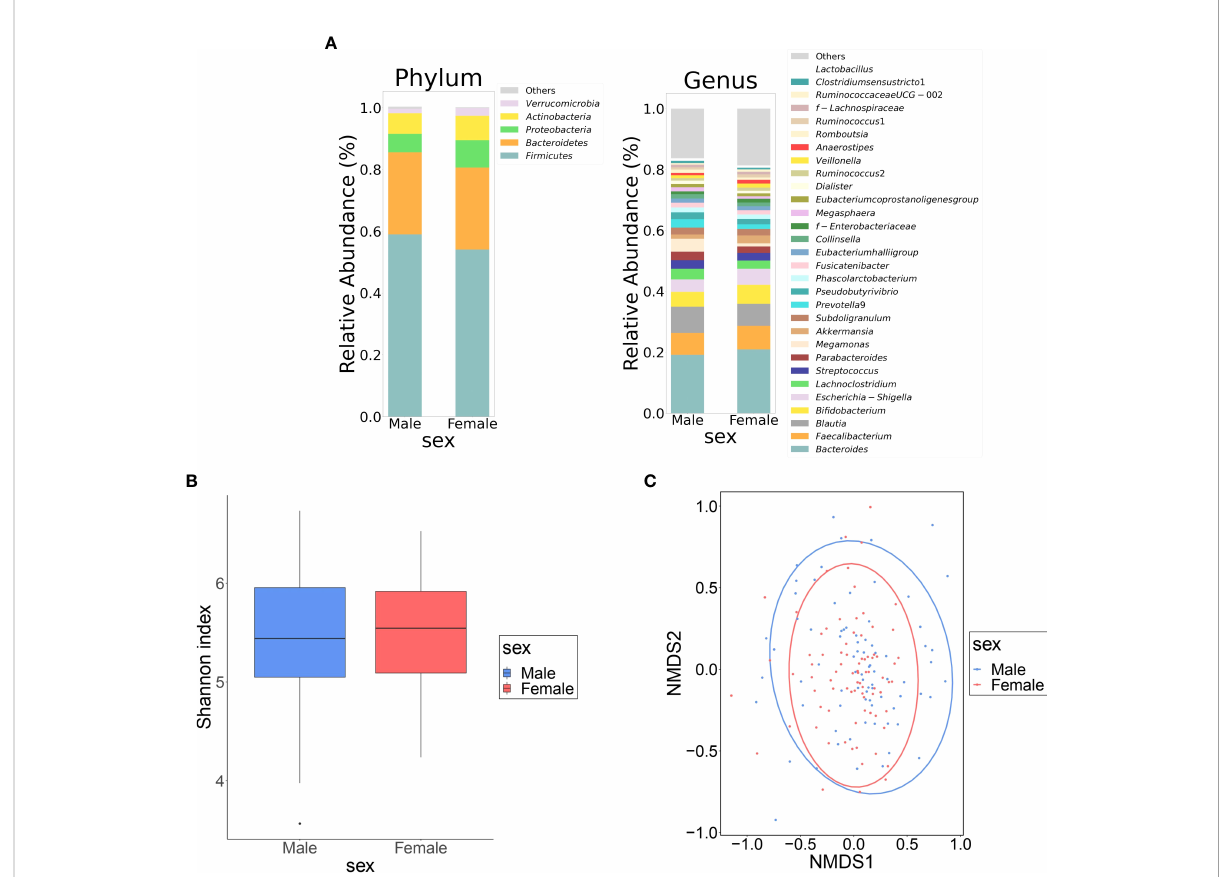
FIGURE 1 Differences in gut microbiota between female and male groups. (A) Comparison of relative abundance ratios at the phylum and genus level for the top 30 bacterial genera with mean abundance ratios by sex. (B) The difference in a -diversity calculated using Shannon index, 5,000 depths. One sample that failed to be sequenced was excluded. ( P = 0.490, Quade ’ s nonparametric ANCOVA) (C) Plot of b -diversity analysis calculated by NMDS ordering based on Bray-Curtis distance matrix. Red: female, blue: male. Ellipses represent 95% con fi dence intervals for each genus used in the analysis. ( P = 0.953, PERMANOVA) NMDS: non-metric multidimensional scaling; ANCOVA: analysis of covariance; DL: dyslipidemia; PERMANOVA: permutation multivariate analysis of